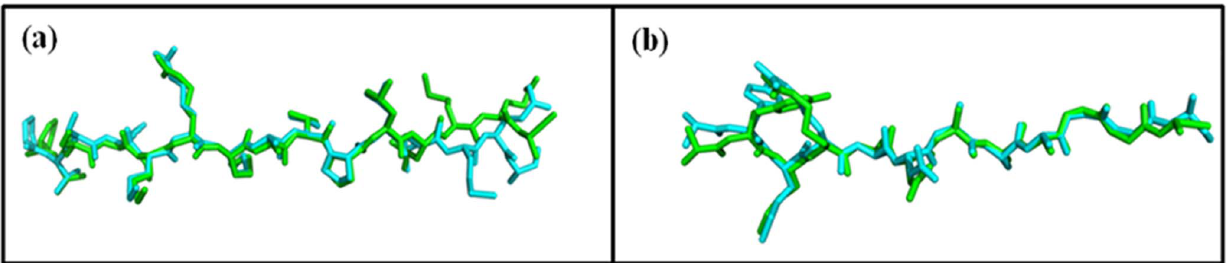
Figure 5. Docking validation. Results of poses derived from validation of the docking procedure showing (a) superposition of the docked pose from the extracted coordinates of human collagen II peptide and its native crystal state in I-Ab (PBD code: 1MUJ) and (b) superposition of the docked pose from the extracted coordinates of CLIP and its native crystal state in HLA DR4 (PBD code: 2SEB). The co-crystallised peptides are coloured green while the complementary docked peptides are shown in cyan.